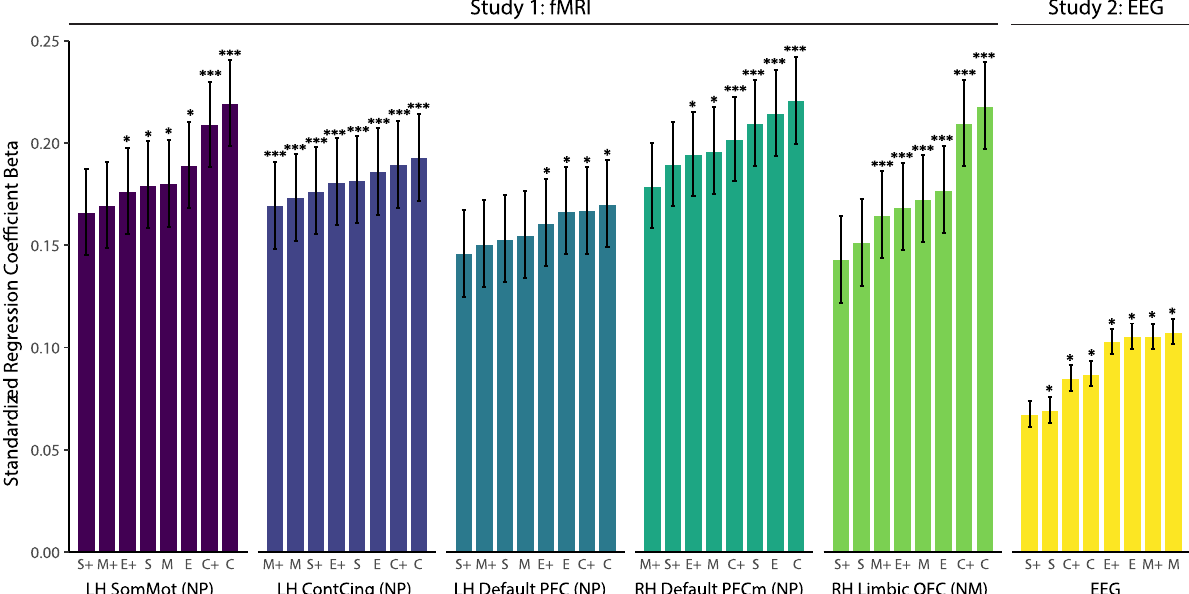
Figure 4. Estimates of the relationship between personality similarity and neural synchrony using four different similarity metrics. The relationship between personality similarity and neural synchrony was consistent across coefficients and multiple model specifications (4 personality similarity measures × 2 models, one with- and one without controls). All coefficients are standardized effects sorted by effect size within each brain region for which significant effects were found in the fully controlled model (fMRI) as well as for the whole brain analyses (EEG). LH left hemisphere, RH right hemisphere, NM neural magnitude synchrony, NP neural pattern synchrony, SomMot somatomotor cortex, ContCing cingulate cortex parcel within frontoparietal control network, Default PFC prefrontal cortex parcel within default mode network, Default PFCm medial prefrontal cortex parcel within default mode network, Limbic OFC orbitofrontal cortex parcel within limbic network. The coefficients are labelled with the respective reverse-coded distance measure, with E Euclidean, M Manhattan, C Canberra, and S Supremum. The + sign denotes models that include the socio-demographic similarity measures as control variables. Asterisks indicate permutation-tested and FDR corrected significance levels with * p < 0.05, ***p <